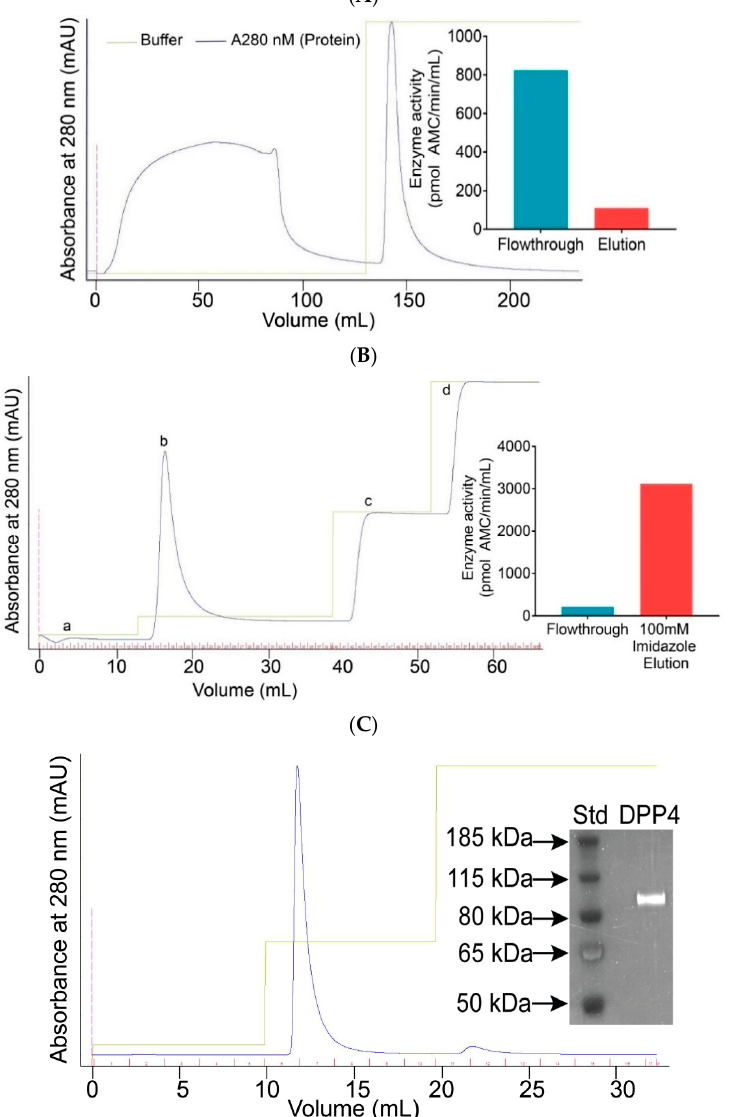
Figure 2. Elution profiles of DPP4 chromatography. ( A ) Chromatogram from Phenyl Sepharose that was equilibrated with 12% ammonium sulphate (AS) in 10 mM Tris-HCl pH 7.6 and eluted with 0% AS in 10 mM Tris-HCl pH 7.6 buffer. Inset: Fibroblast activation protein (FAP) activity. ( B ) Chromatogram from Nickel Sepharose, which was equilibrated with 20 mM imidazole in 200 mM NaCl, 10 mM Tris-HCl, pH 7.6 and eluted with an increasing concentration gradient of imidazole at 30 mM (a), 100 mM (b), 500 mM (c), 1000 mM (d) in 10 mM Tris-HCl pH 7.6 buffer. Inset: FAP activity. ( C ) Chromatogram from DEAE Sepharose that was equilibrated with 10 mM Tris-HCl pH 7.6 and eluted with 200 mM NaCl in 10 mM Tris-HCl pH 7.6 bu ff er. Inset: sodium dodecyl sulphate polyacrylamide gel electrophoresis (SDS–PAGE; 4–12% Bis-Tris gel) of the resulting purified soluble DPP4, stained with Sypro ruby Protein was measured by optical density at 280 nm in these chromatograms. Blue Sepharose dye a ffi nity chromatography binds to albumin and some other contaminants [44] and did not bind to DPP4. DPP4 protein was then captured from the solution by IMAC that